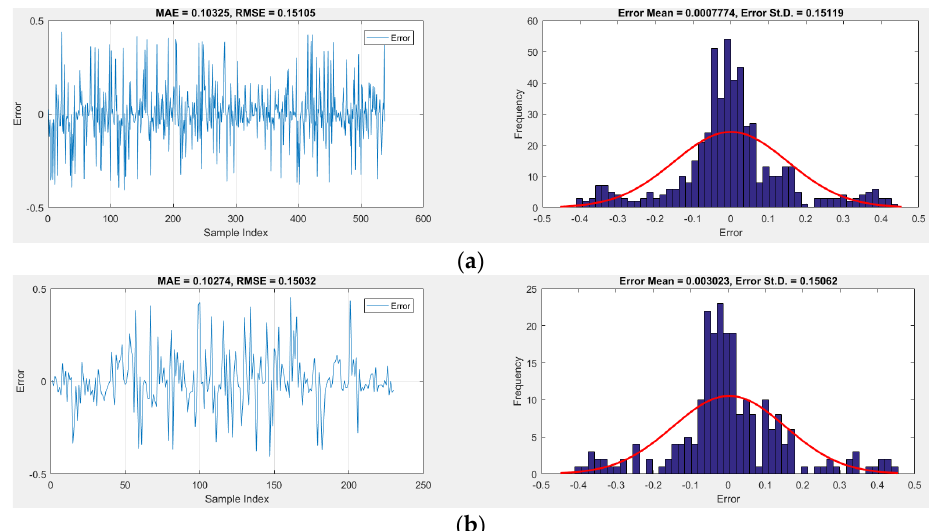
Figure 10. Frequency and minimum value of errors in HHO − ANFIS − 500 best fit structure. ( a ) Training dataset. ( b ) Testing dataset.